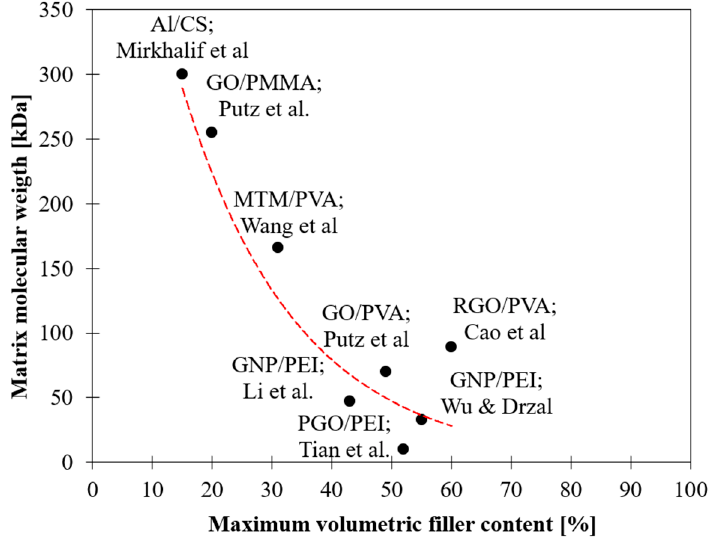
Figure 5. Dependence of drop off point on matrix molecular weight.